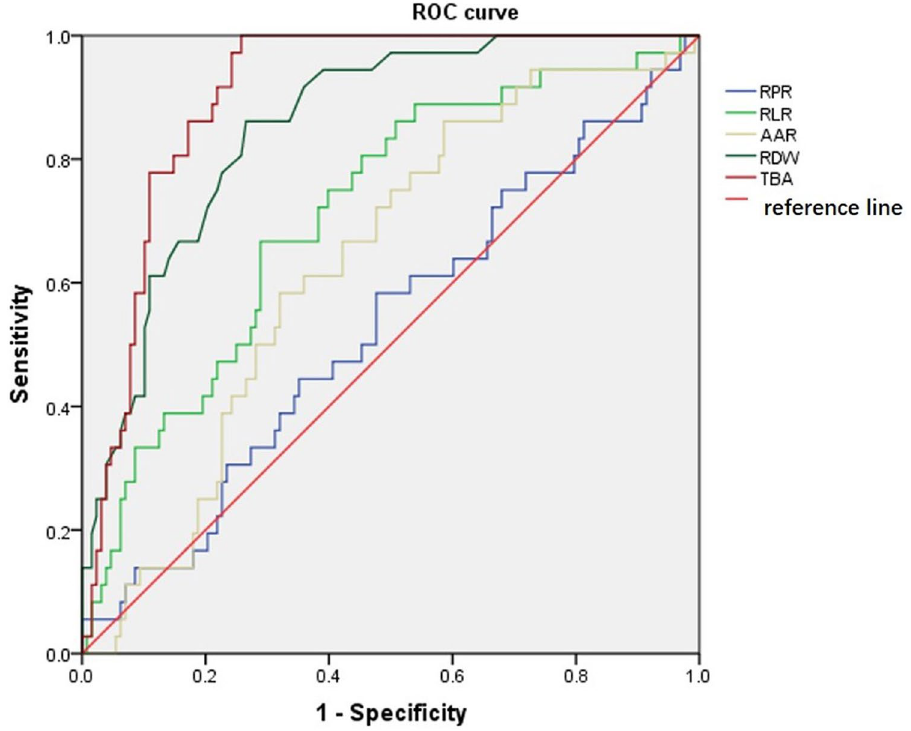
Figure 1. Receiver operating characteristic (ROC) curves of red blood cell distribution width (RDW), RDW- to-platelet ratio (RPR), RDW-to-lymphocyte ratio (RLR), total bile acid (TBA), and aspartate transaminase-to- alanine aminotransferase ratio (AAR) for diagnosis of severe